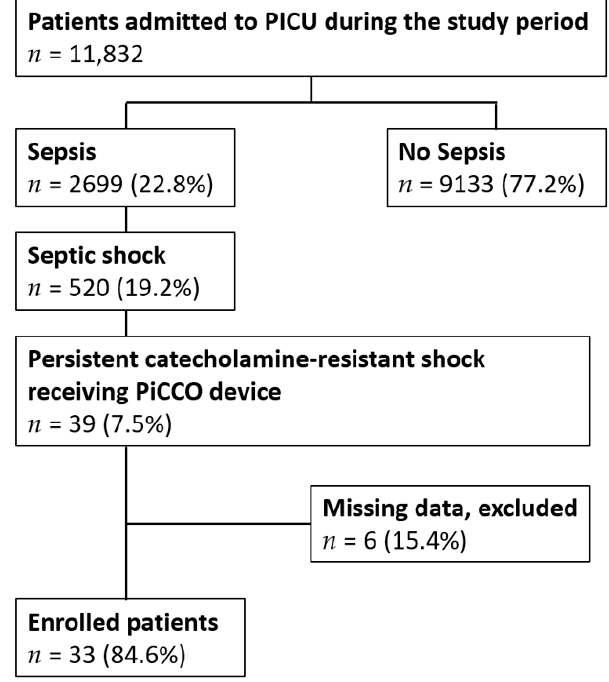
Figure 1. Algorithm of enrolled patients.